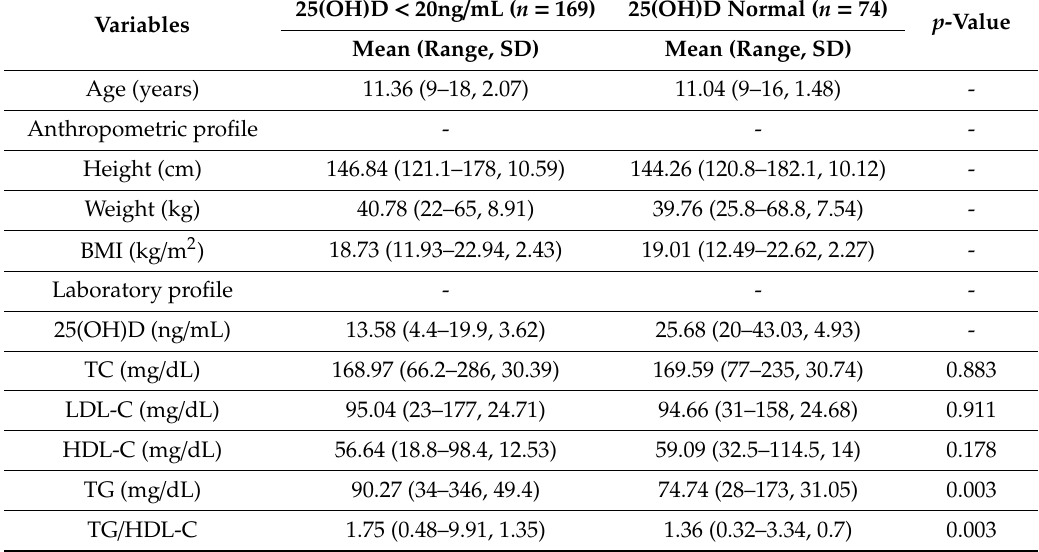
Table 2. Comparison of the characteristics at different vitamin D levels.